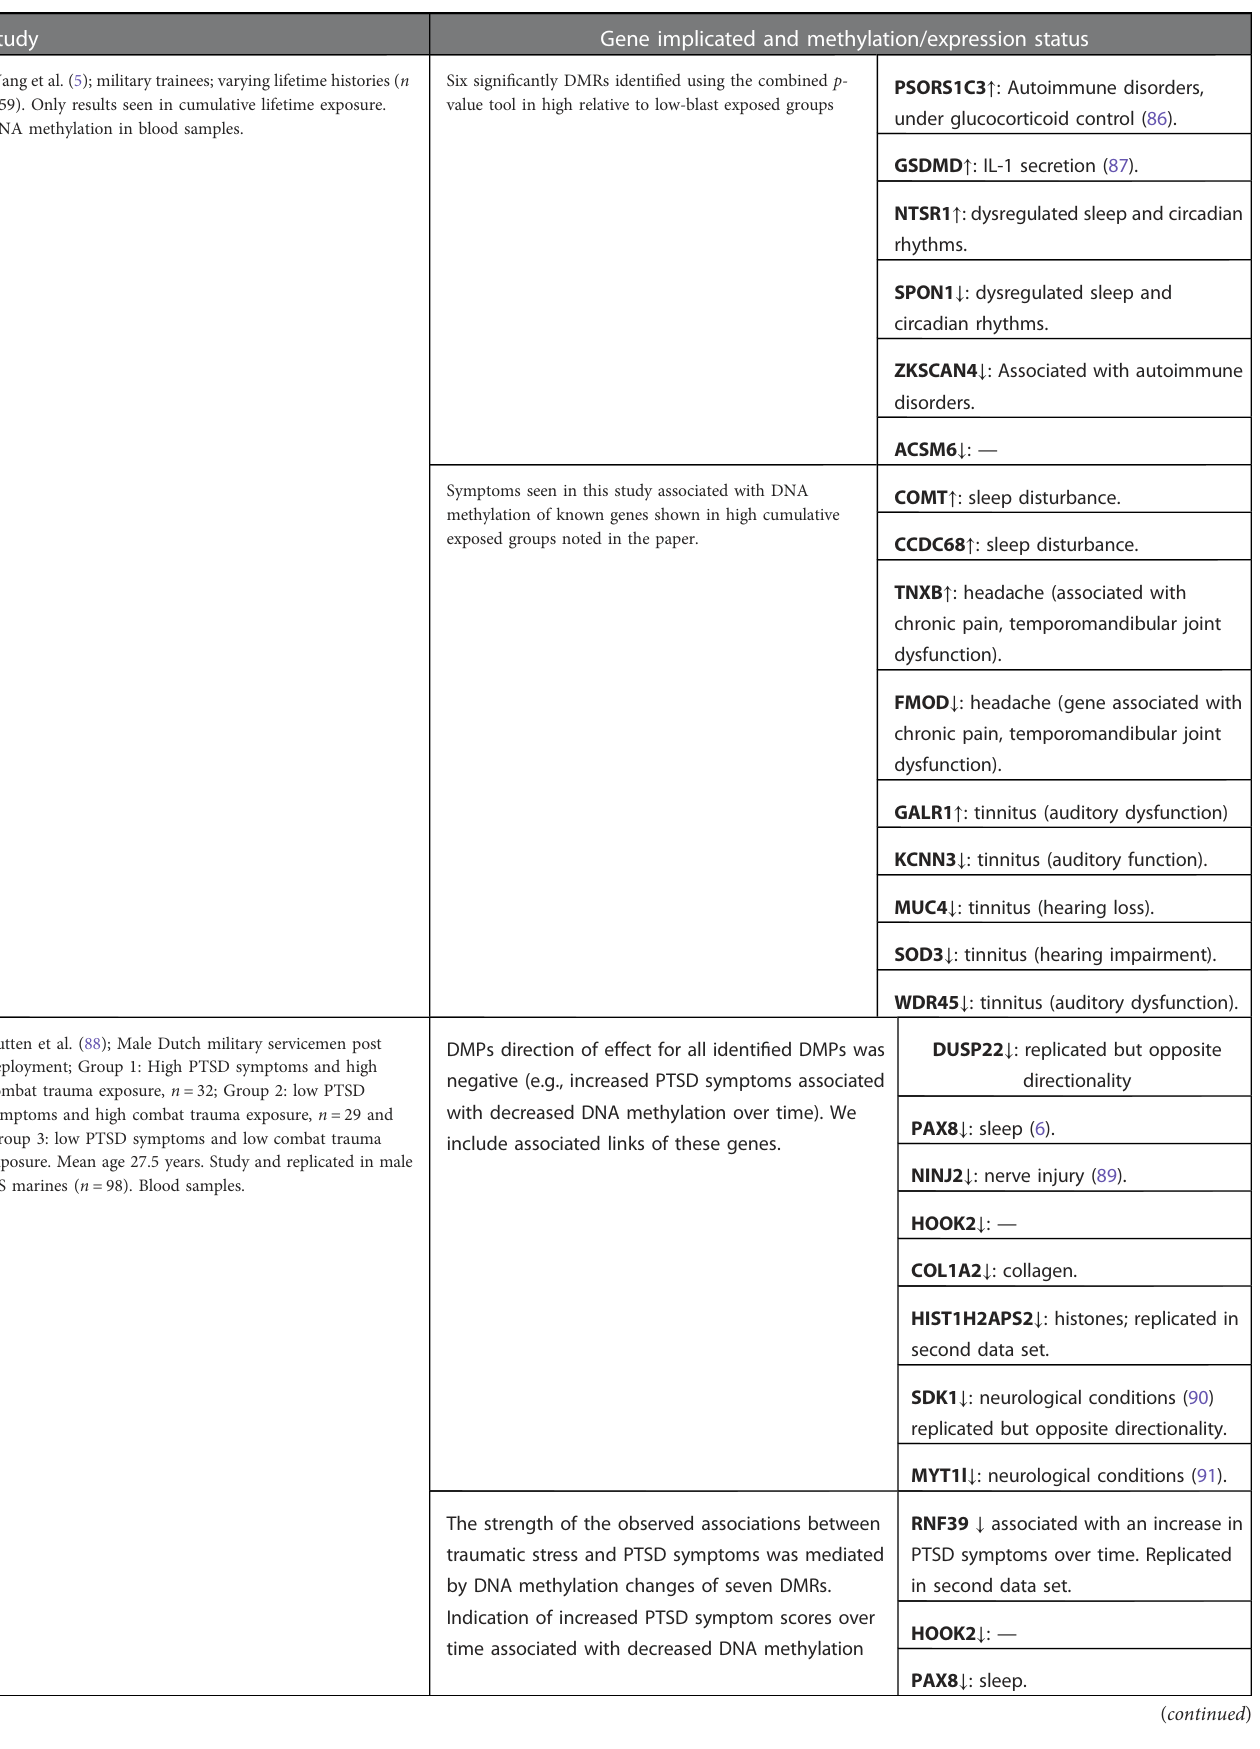
Study Gene implicated and methylation/expression status Wang et al. (5); military trainees; varying lifetime histories ( n =59). Only results seen in cumulative lifetime exposure. DNA methylation in blood samples.